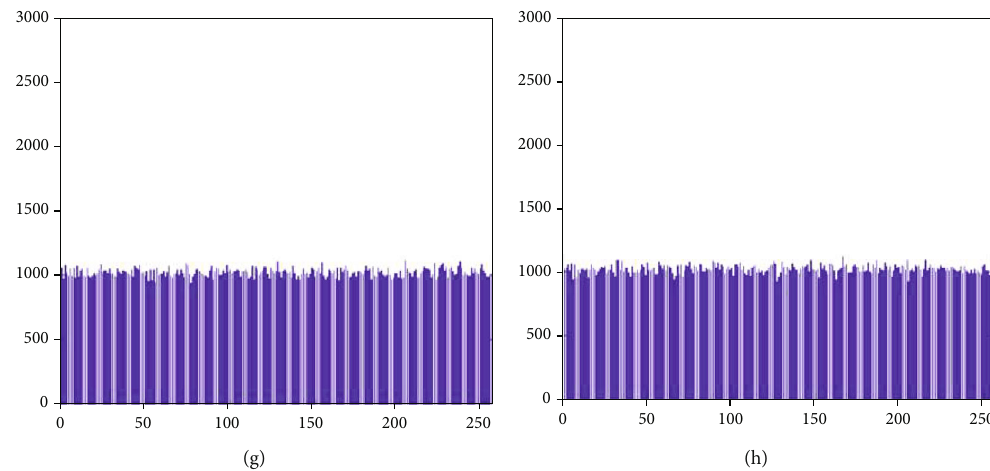
Figure 6: Histogram analysis. (a) Plaintext of 2.1.11_color. (b) Histogram of 2.1.11_R. (c) Histogram of 2.1.11_G. (d) Histogram of 2.1.11_B. (e) Table 1: Correlation coe ffi cients of images.